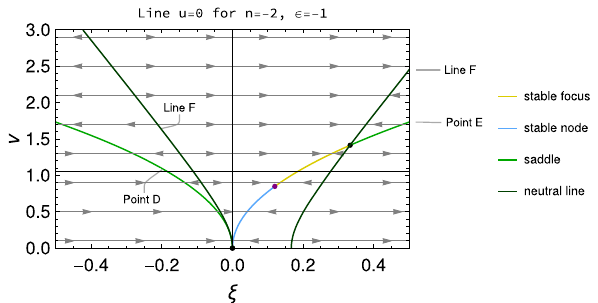
Fig. 10 Bifurcationdiagram ofthelocalstabilityofequilibrium points of system (25) on the u = 0 line under variation of the parameter ξ for fixed n = − 2 and ε = − 1. The black dot in this diagram denotes a non-hyperbolic equilibrium point, while the purple dot denotes a stable degenerate node. Grey arrows show the direction of the flow on the u = 0 line – arrows directed to the right denote the flow following towards increasing values of u , whereas arrows directed to the left denote the flow following towards decreasing values of u . The flow on the u = 0 line is perpendicular to this line since on it v (cid:7) = 0 in system